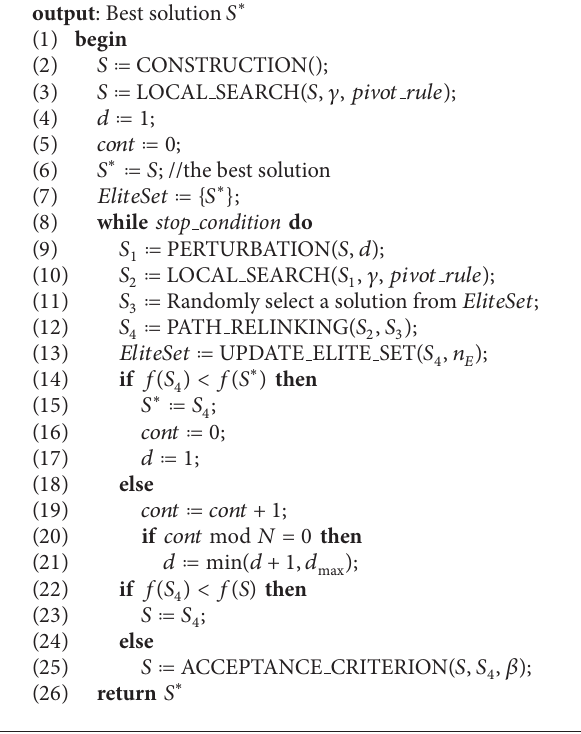
Table 1: Input data for an instance with 7 jobs and 2